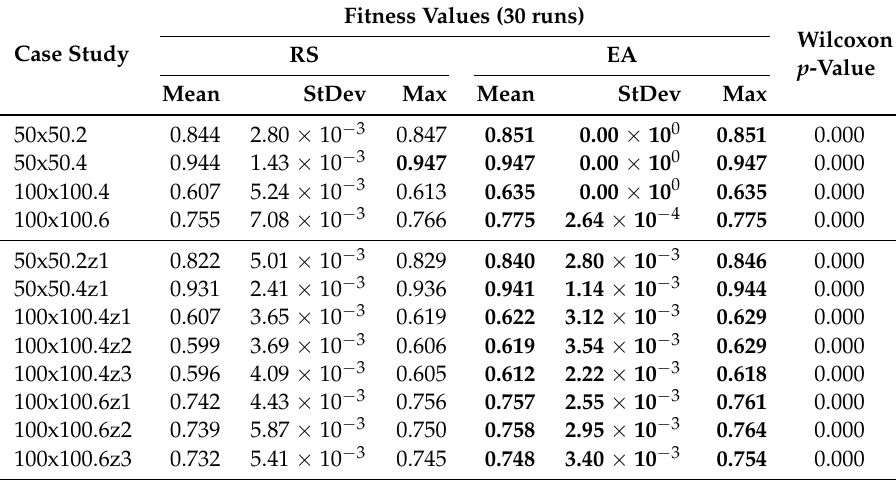
Table 5. Results of the optimisation process performed by EA and RS and the Wilcoxon p -value of each statistical test. We report the fitness values obtained from 30 runs of each algorithm on the 12 case studies (four without UZs and eight having two UZs) comprising 30 instances (scenarios) each (720 optimisation runs in total). Best fitness values are in bold.